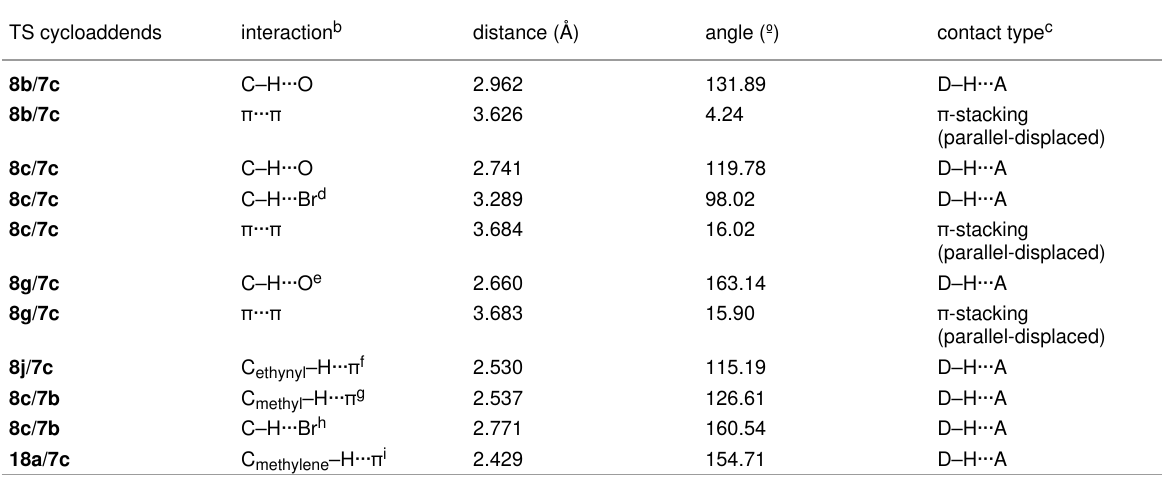
Table 7: Calculated [M06-2X/6-31+G(d,p)] NCIs, including distances, angles and contact type from the ZPE-corrected geometry of each of the endo TSs of the Diels–Alder reactions of dienes 8b , 8c , 8g , 8j and 18a with dienophiles 7b , c . a